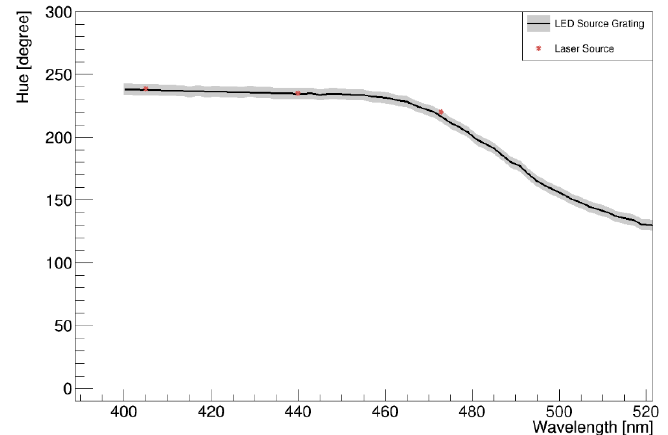
Figure 9. H-W response deduced using laser modules with wavelength 375, 405, 440, and 473 nm. Our camera did not respond to the 375 nm light source.